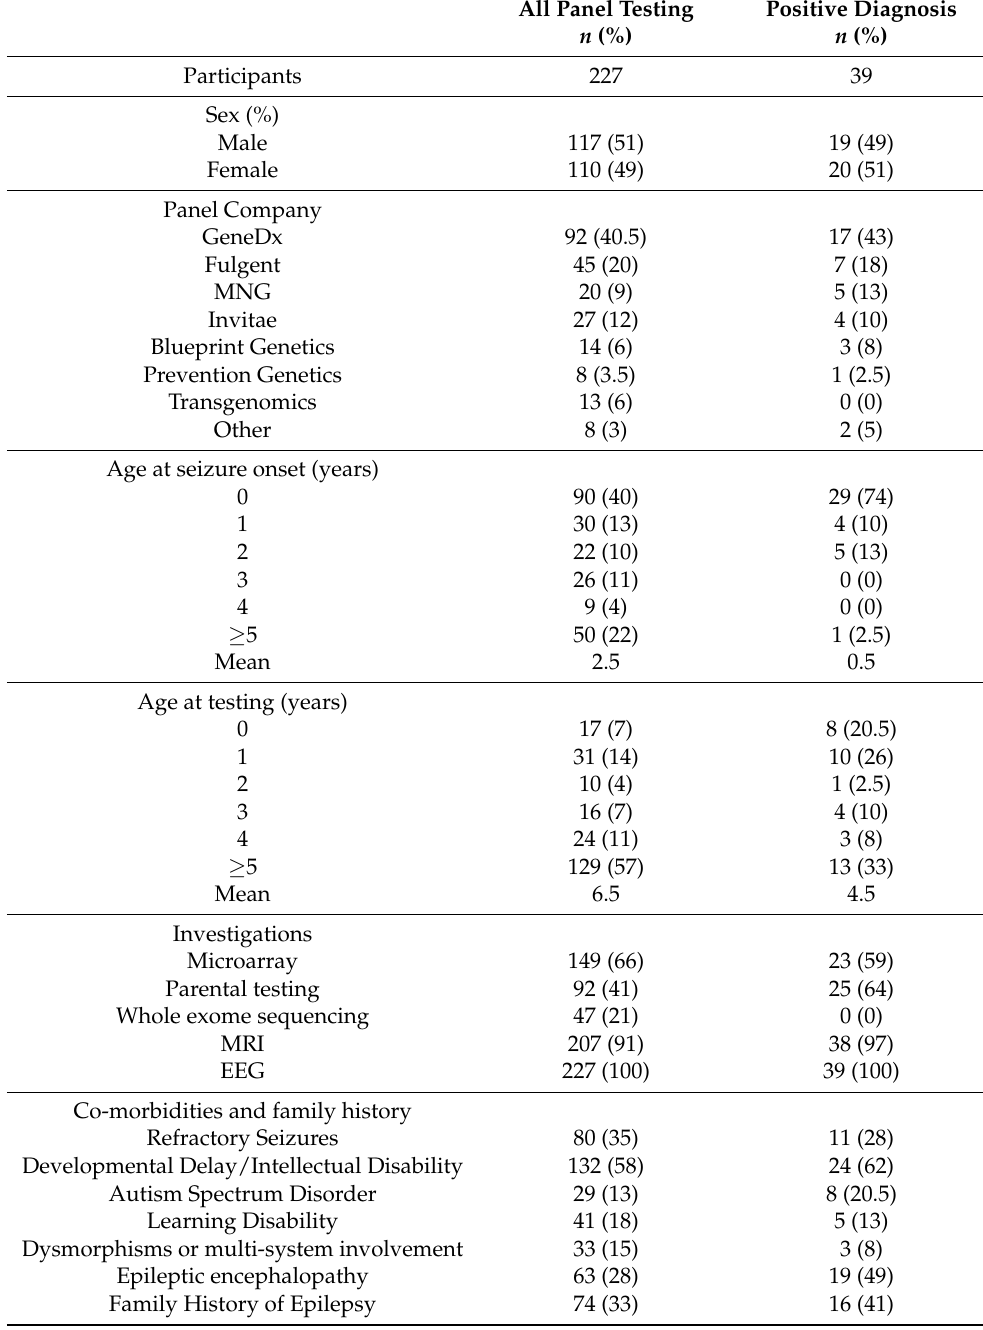
Table 1. Summary of results of epilepsy panel